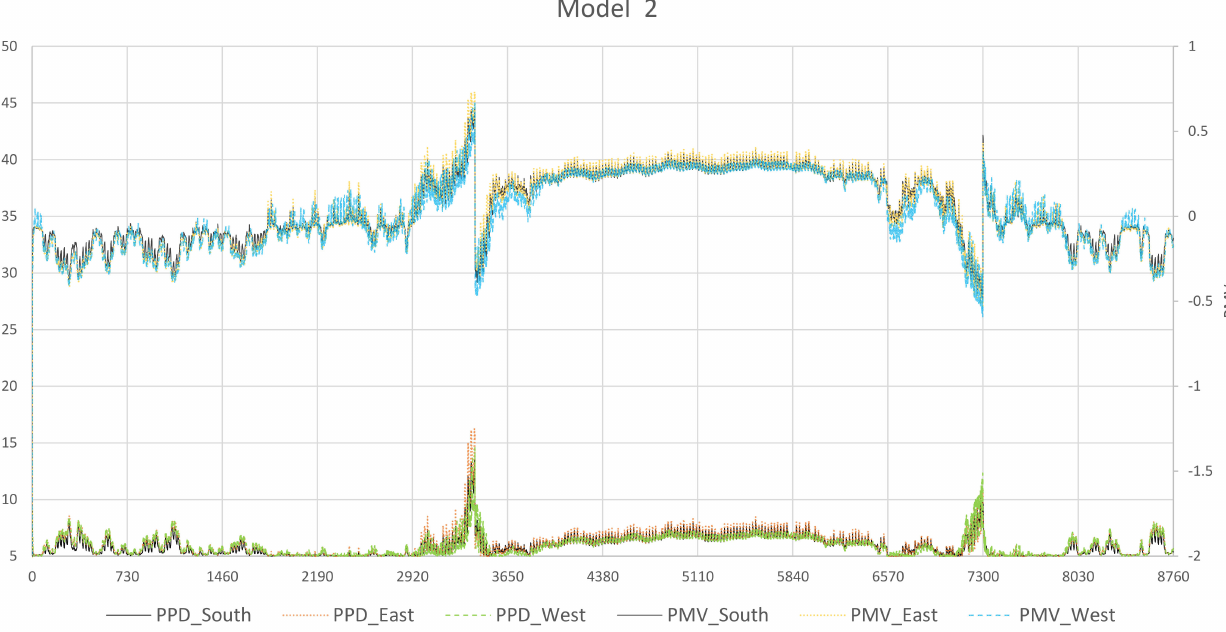
Figure 5. PPD and PMV values for Model 2 in different areas (south, east, and